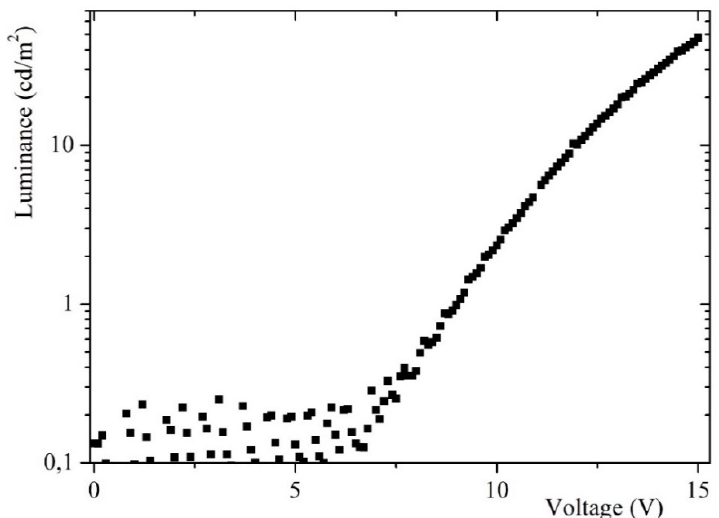
Polymers 2019 , 11 , x FOR PEER REVIEW Figure 5. Luminance versus voltage characteristic of the device realized with the 10 wt.% C1-PVK blend.